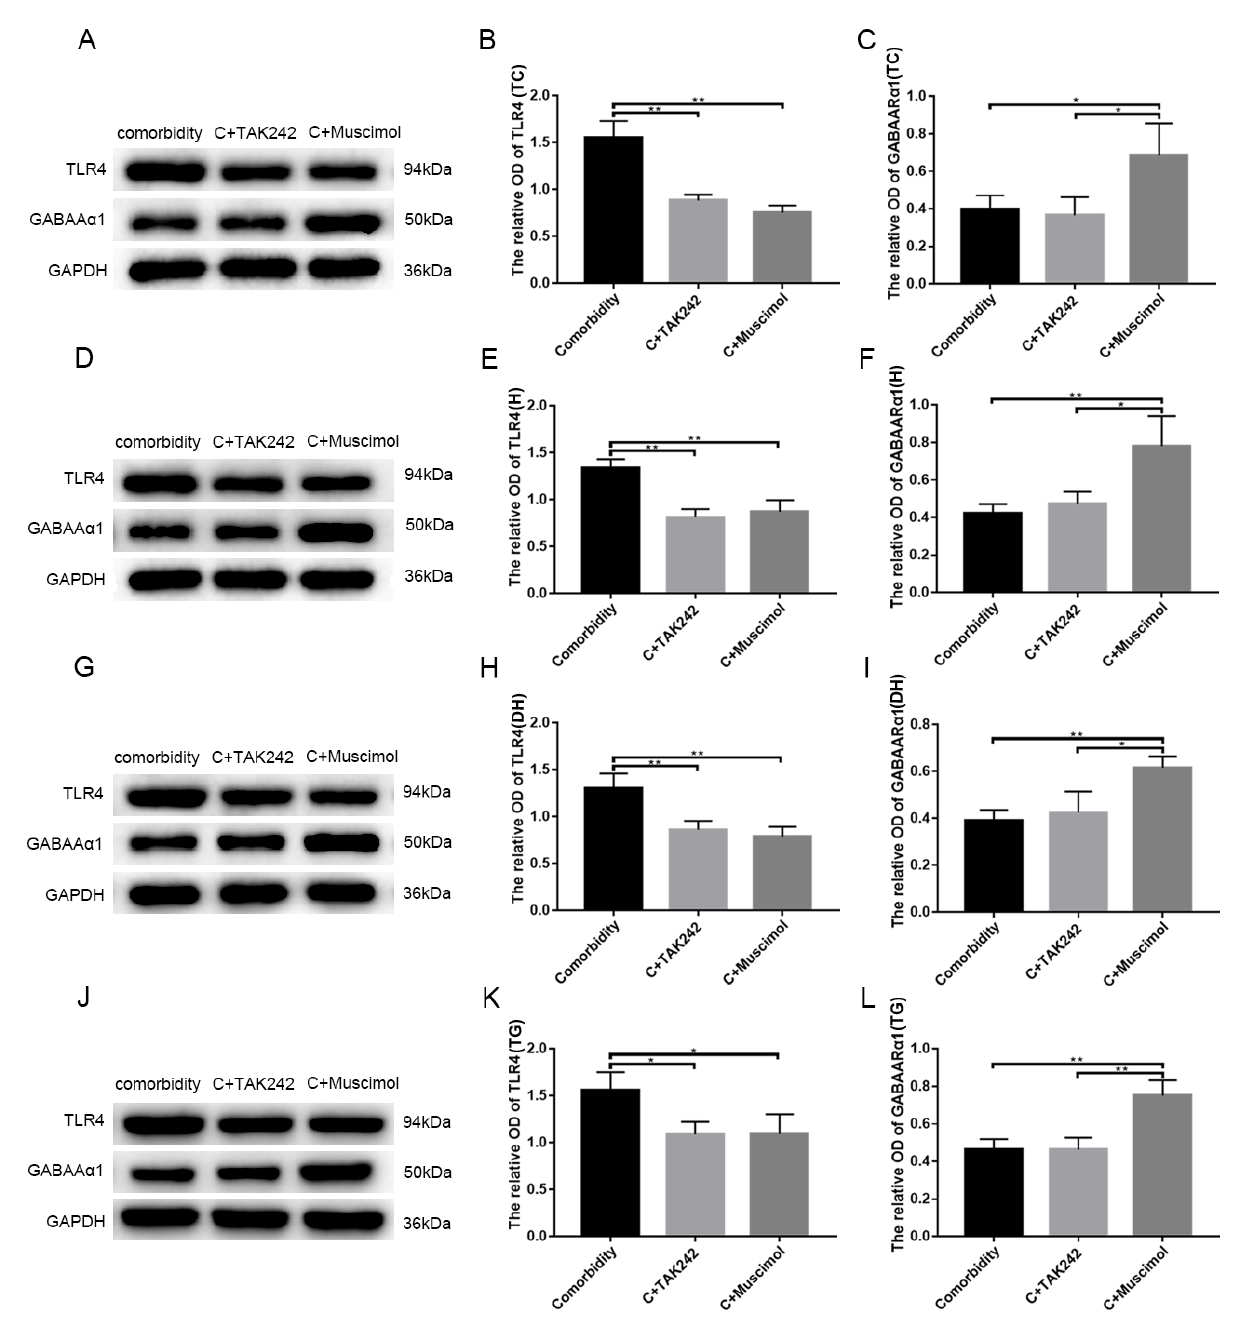
Figure 7. GABAAR α 1 negatively regulates TLR4 expression. Using TAK-242 to inhibit TLR4 or Muscimol to activate GABAAR α 1, Protein was collected from the temporal cortex ( A ), hippocampus ( D ), medullary dorsal horn ( G ), and trigeminal ganglion ( J ) of comorbidity, comorbidity + TAK-242, and comorbidity + Muscimol rats. Protein extracts were immunoblotted with antibodies to TLR4, GABAAR α 1, GAPDH used as a gel loading control. The results are expressed as densitometric units normalized to GAPDH ± SEM. The TLR4 levels were lower in comorbidity + TAK-242 and comorbidity + Muscimol groups compared with the comorbidity group ( n = 3, * p < 0.05, ** p < 0.01) ( B , E , H , K ). The GABAAR α 1 levels were higher in comorbidity + Muscimol group compared with the comorbidity and comorbidity + TAK-242 groups ( n = 3, * p < 0.05, ** p < 0.01) ( C , F , I , L ). TC: temporal cortex, H: hippocampus, DH: medullary dorsal horn, TG: trigeminal ganglion, C: comorbidity.